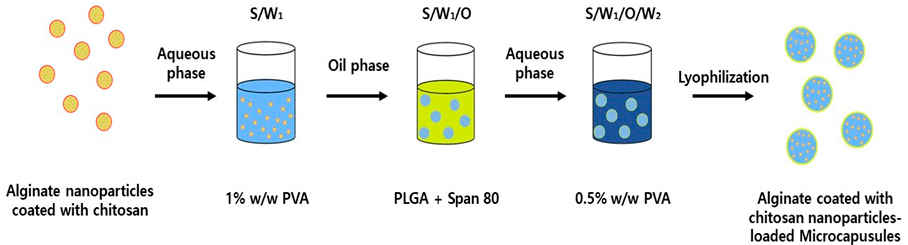
Scheme 1. Schematic illustration of the encapsulation of metoprolol tartrate (MET)-loaded